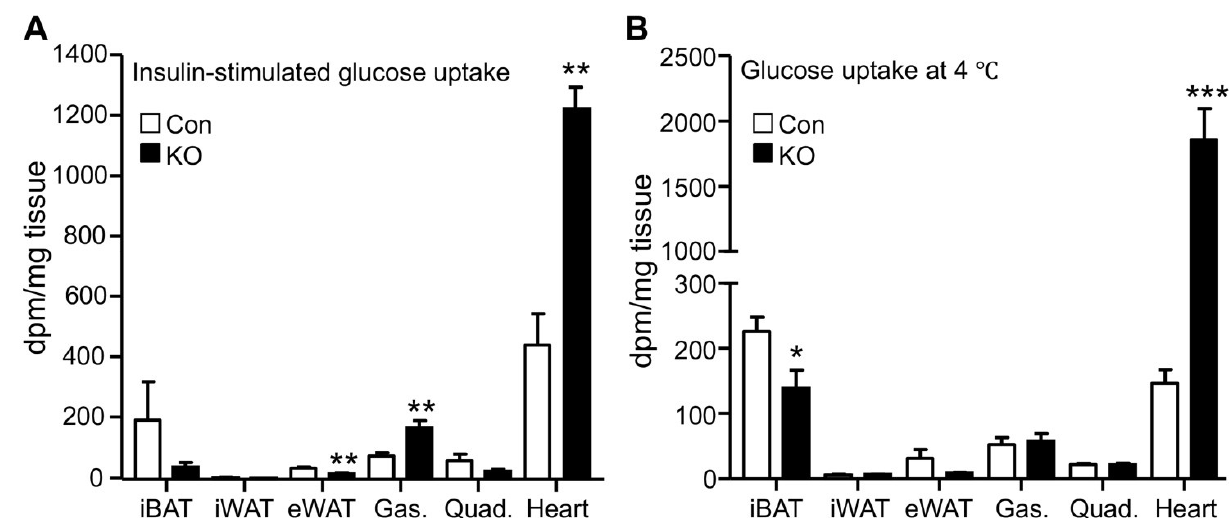
Figure 2. Adipose CGI-58 deficiency increases cardiac glucose uptake. ( A ) Tissue glucose uptake stimulated by insulin in 28-week-old HFD-fed mice housed at room temperature ( n = 4–6/group). ( B ) Tissue glucose uptake in 20-week-old HFD-fed mice during acute cold exposure ( n = 4–5/group). * p < 0.05, ** p < 0.01, and *** p < 0.001 vs. genotype by two-tailed unpaired Student’s t -test. iBAT, interscapular brown adipose tissue; iWAT, inguinal subcutaneous white adipose tissue; eWAT, epididymal white adipose tissue; Gas., gastrocnemius muscle; and Quad., quadriceps muscle.